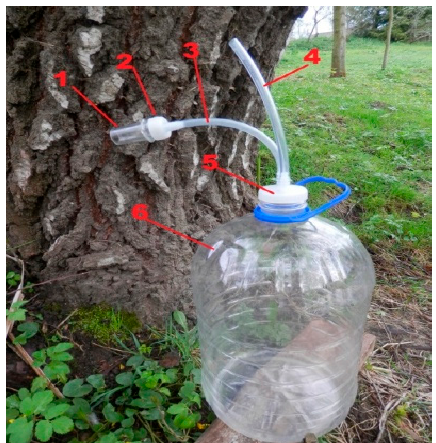
Figure 2. Tapping device components: ( 1 ) implant, ( 2 ) screw-on connector, ( 3 ) plastic tube, ( 4 ) plastic tube for air flow, ( 5 ) screw cap, and ( 6 ) container.